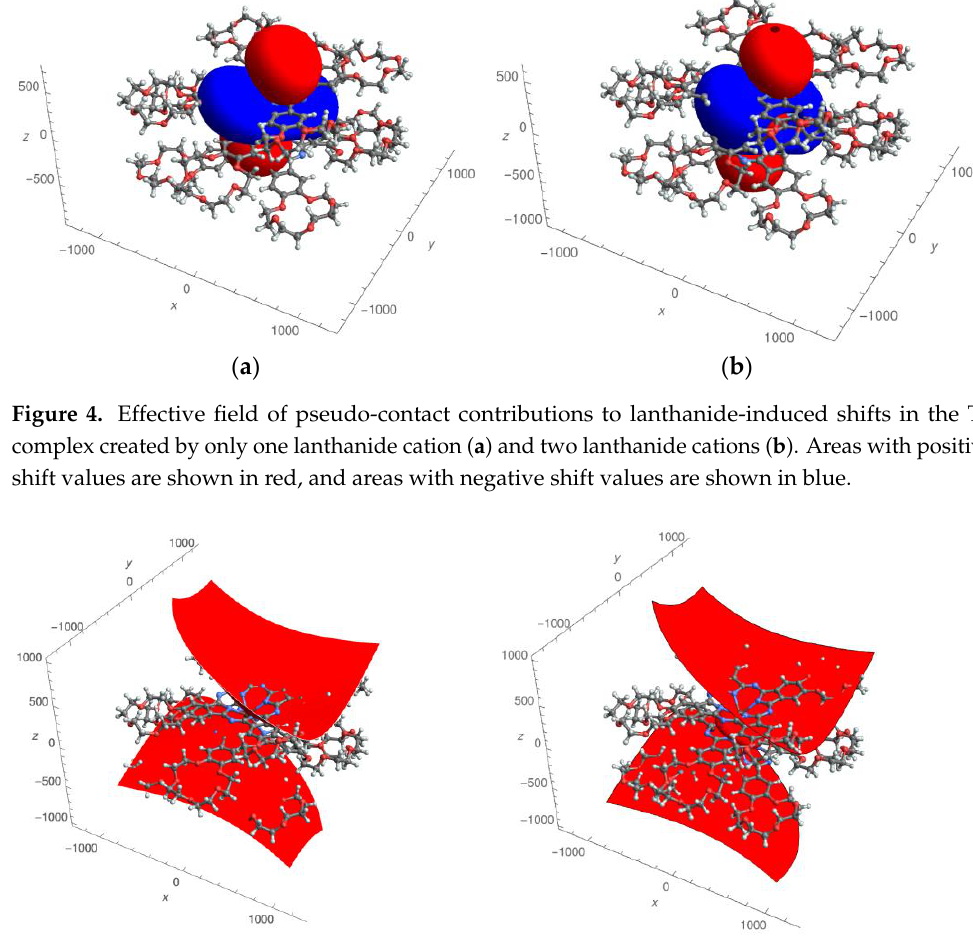
Figure 3. Effective field of the pseudo-contact contributions to lanthanide-induced shifts in the Dy complex created by only one lanthanide cation ( a ) and two lanthanide cations ( b ). Areas with pos- itive shift values are shown in red, and areas with negative shift values are shown in blue.